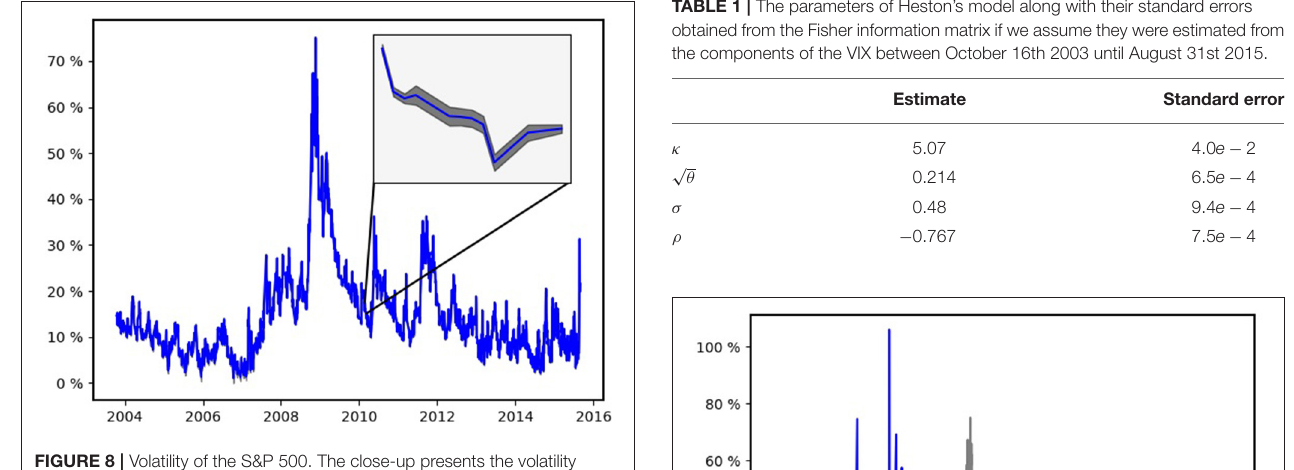
FIGURE 8 | Volatility of the S&P 500. The close-up presents the volatility estimate along with its double standard deviation obtained from Fisher information matrix Equation (3.5).